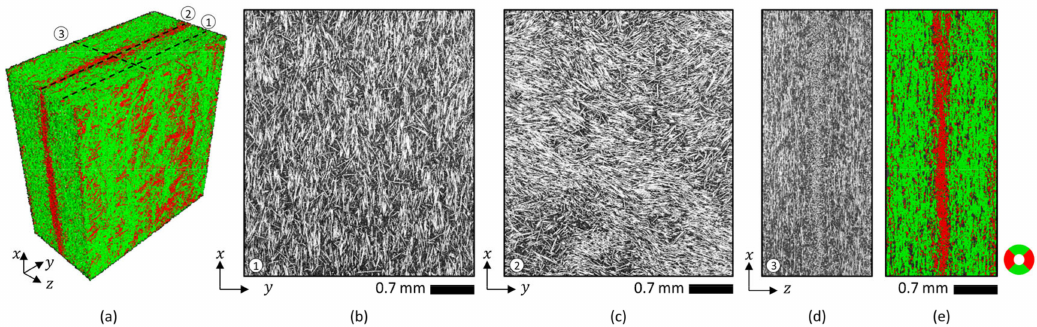
Figure 3. ( a ) Example of three-dimensional µ CT reconstruction of a molded plate’s region (ROI A). Examples of bi-directional cross-sections extracted from the µ CT reconstruction at different positions represented with white dashed lines: ( b ) position 1, ( c ) position 2, and ( d , e ) position 3. Fiber orientation analysis (two-color map showing orientation angles according to the angular scale) is shown both in ( a ) 3D and ( e ) 2D.